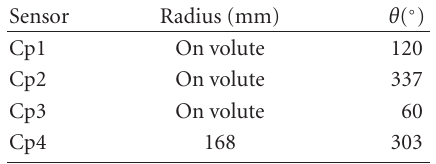
Figure 15: Kistler sensors locations for blade-to-blade measure- ments.